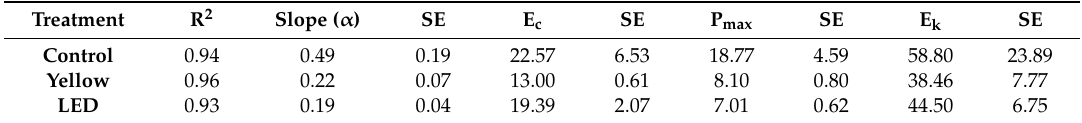
Table 1. PE (photosynthesis-energy) curve parameters. ‘Dark’ (control), ‘Yellow’ (fluorescent), and ‘LED’ (LED) represent the PE curve parameters of the di ff erent treatments. Parameters after fitting to a nonlinear hyperbolic tangent function: R 2 = coe ffi cient of determination; slope ( α ) = maximum light utilization coe ffi cient; E c = Compensation point; E k = minimum saturating irradiance; P max = maximum potential photosynthetic rate; SE = standard error of the